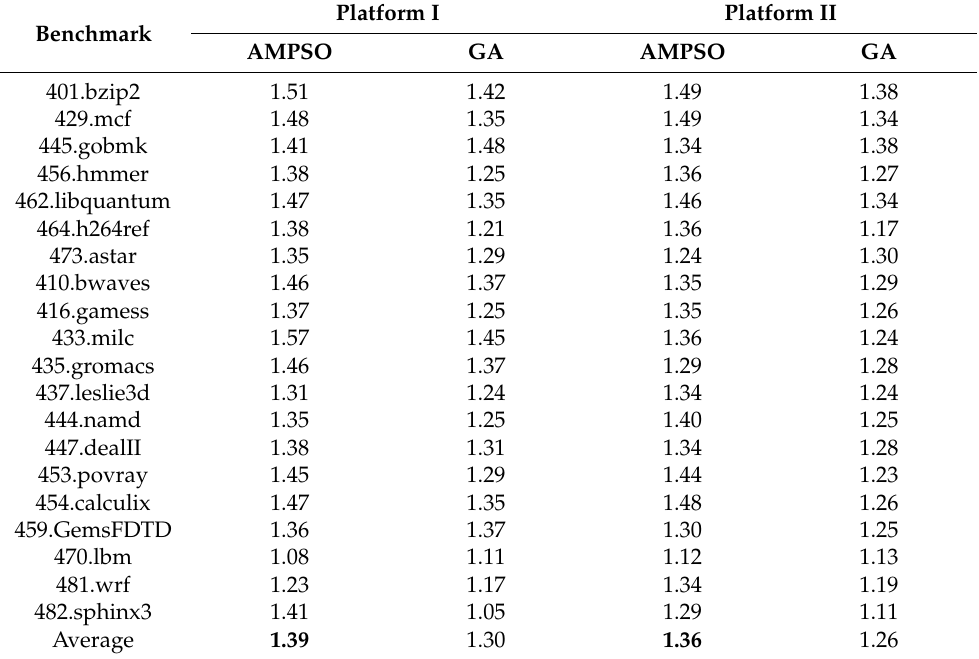
Table 2. Speedup of the SPEC CPU2006